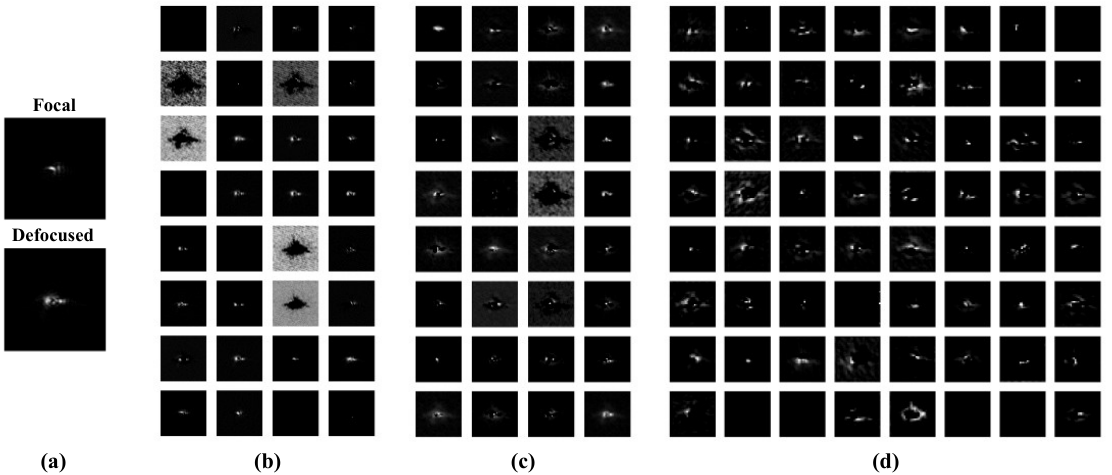
Figure 6. The output feature maps from ( b ) convolution layer 1, which are 32 images of 128 × 128 pixels, ( c ) convolution layer 2, which are 32 images of 64 × 64 pixels, and ( d ) convolution layer 3, which are 64 images of 32 × 32 pixels, when the input a pair of focal and defocused images of test data set shown in ( a ) to the trained PD-CNN.